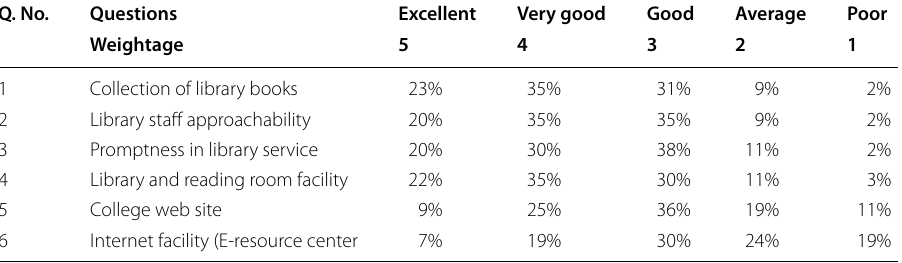
Table 4 Statistical analysis of data obtained for feedback Table no. Table 1 Table 2 Table